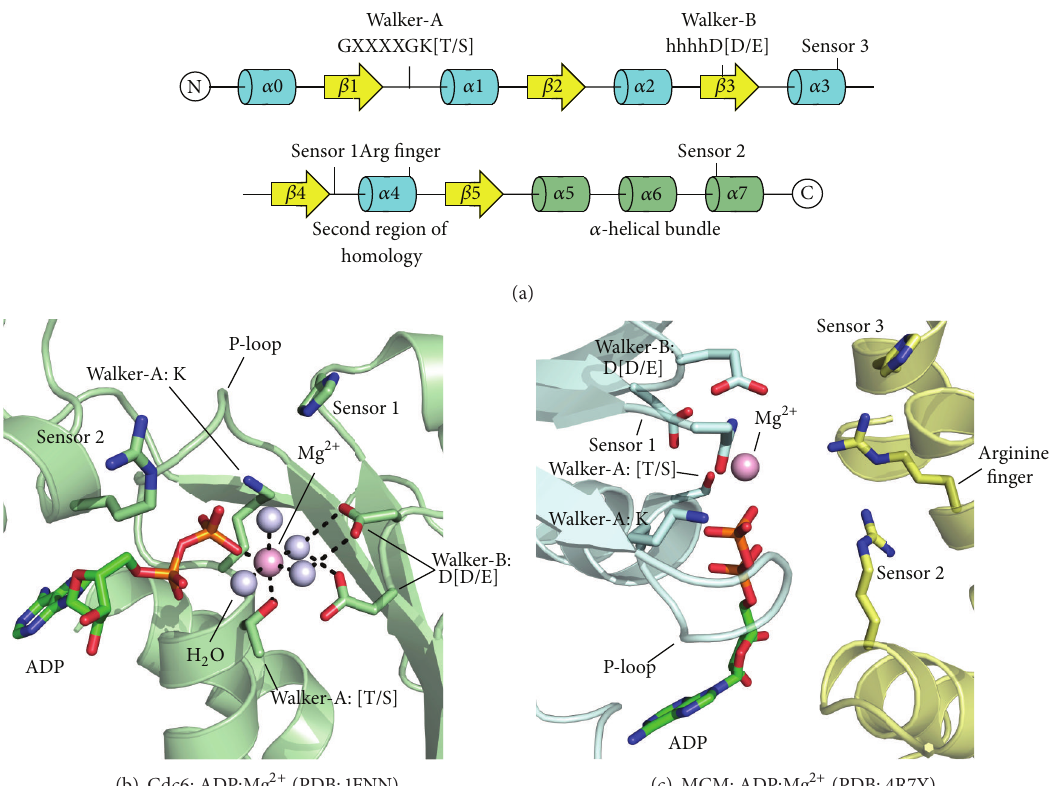
Figure 1: Features of the AAA+ ATPase domain. (a) The AAA+ 𝛼 - 𝛽 - 𝛼 fold topology and active site feature locations are shown in primary sequence and secondary structure. Helices and strands within the core 𝛼 / 𝛽 fold are colored in blue and yellow, respectively. C-terminal lid domain helices are colored in light green. (b) Active site residues are precisely positioned to bind nucleotide and Mg 2+ . The Mg 2+ cation is directly coordinated by the Walker-A threonine, the 𝛽 -phosphate of the bound nucleotide, and four water molecules. Dashed lines indicate discussed molecular interactions (see text). The bound ADP molecule and critical active site features are shown in stick, water molecules as light blue spheres, and the magnesium ion as a magenta sphere. (c) The ATPase site forms at subunit interfaces by residues of adjacent subunits. The Walker-A, Walker-B, and Sensor 1 residues are positioned on the left side of the site and all reside on the same subunit (blue, “ cis -acting”), while three basic residues are located on the right side of the site from the neighboring subunit (yellow, “ trans -acting”). Bound ADP and Mg 2+ are represented identical to (b). The protein topology cartoon in (a) was prepared using the TopDraw software package [42]. All structure representations in the figure were prepared with the Pymol software package [43] and PDB accession codes 1FNN [15] (b) and 4R7Y [41]